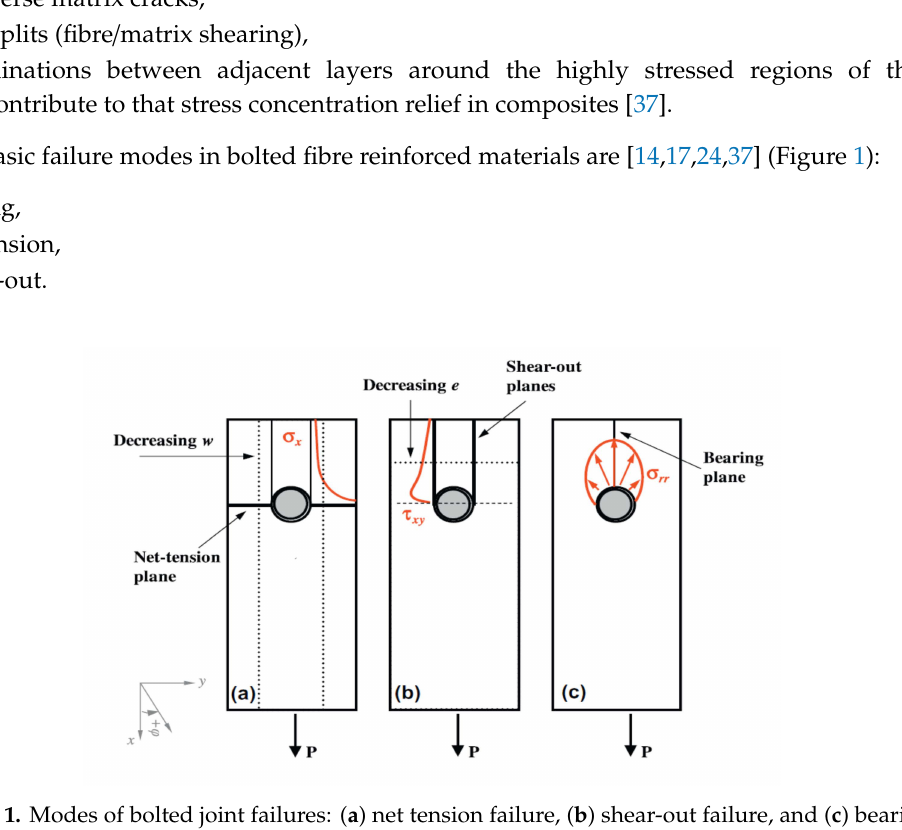
Figure 1. Modes of bolted joint failures: ( a ) net tension failure, ( b ) shear-out failure, and ( c ) bearing along with critical stress distribution